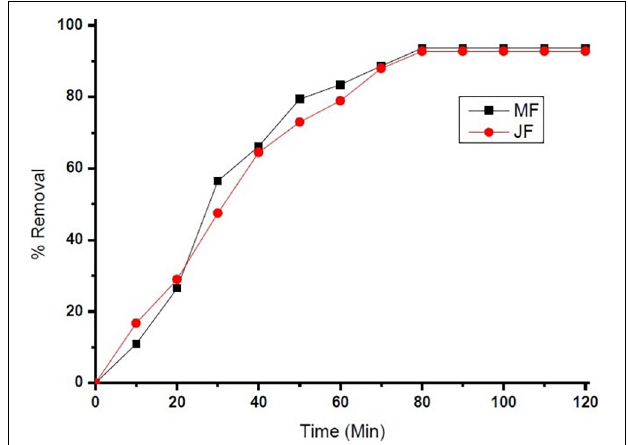
FIGURE 9 | chromium % removal on Mango (MF) and Jack fruit (JF) kernel biomass (contact time = 80 min, pH = 4.8, initial concentration = 2.5 mg. L − 1 , agitation speed = 400 rpm, room temperature).